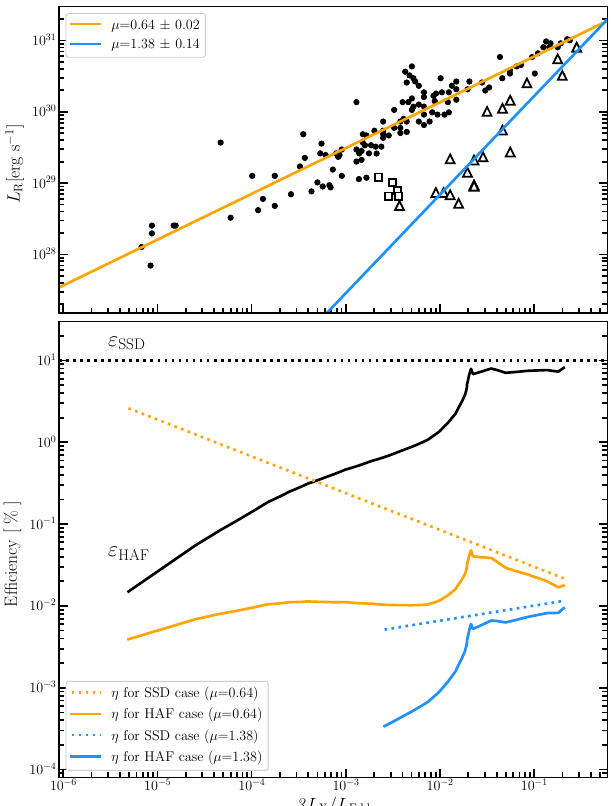
Figure 1. The upper panel shows the radio-X-ray correlation of BHXBs with data taken from [30]. In this plot, the filled circles are those of the standard track, while the open triangles are those of the steep track. The fitting results are also shown here, where we assume BH mass is 10 M panel shows the jet production efficiency η based on the radiative efficiency ε of various accretion flow models (dotted lines for η of SSD and solid lines for η of the hot accretion flow, with different colors corresponding to the different slopes µ ). For the sake of completeness, we also show in the lower panel the radiative efficiency of SSD and HAF taken from [34] by the black-dotted and black-solid lines,